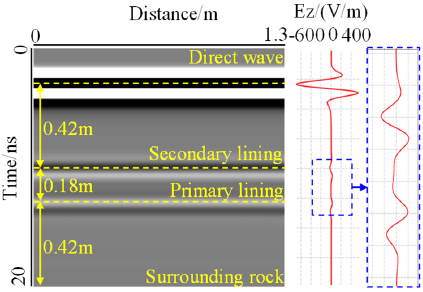
waves fluctuated at the interfaces. The thickness of each layer is close to that in the forward